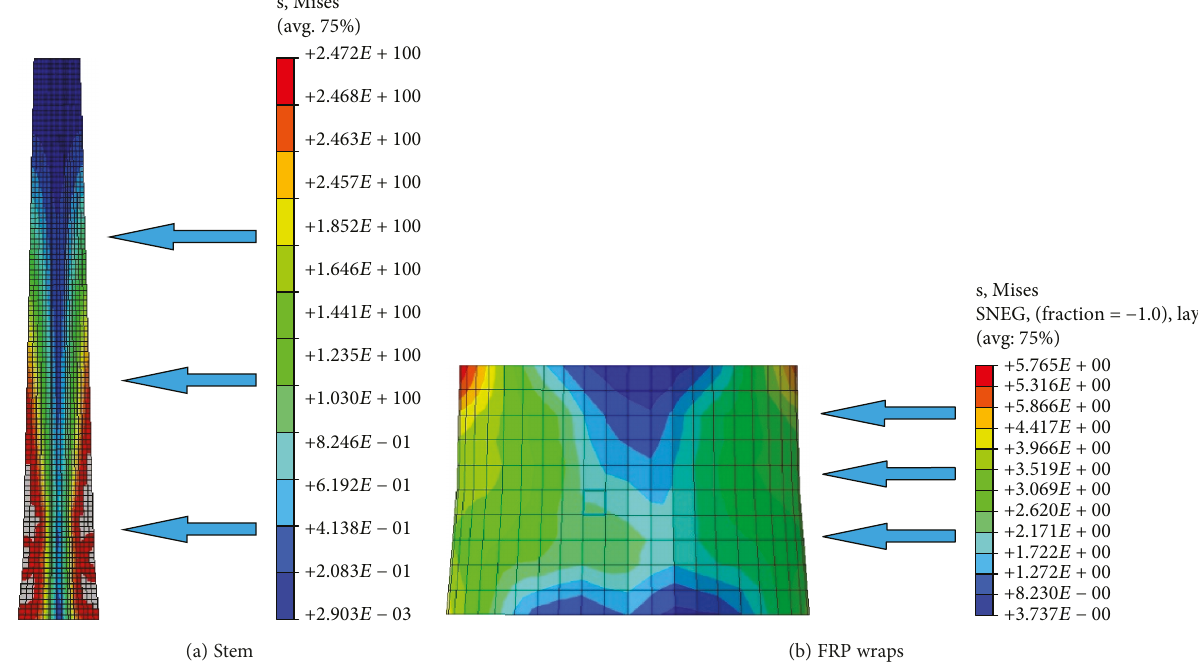
Figure 13: Stress contours when yielding occurs in the stem: (a) stem and (b)